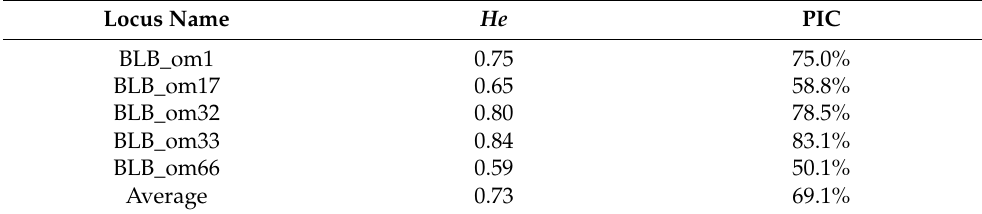
Table 4. Diversity indices of the five microsatellite loci developed for Ootheca mutabilis . Heterozygosity and polymorphic information content are He and PIC,